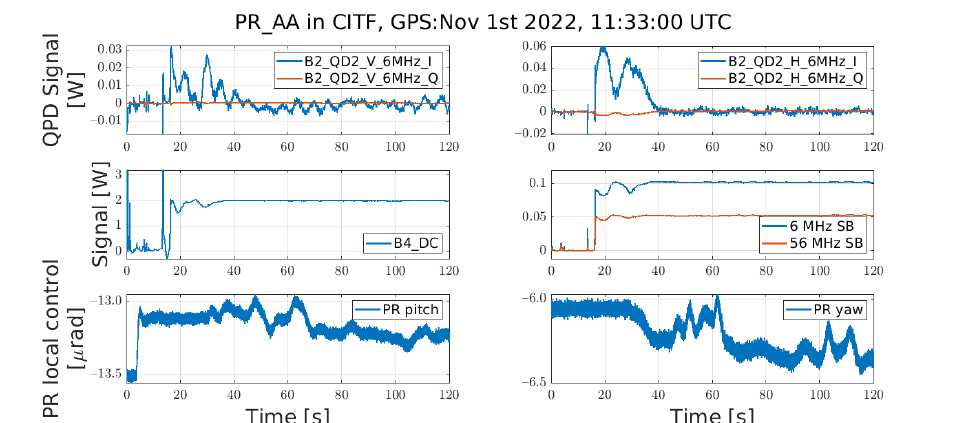
Figure 13. Example of the engagement of the angular control of the PR mirror after the lock of the DRMI. The top plots show the I and Q projections of the angular error signals for yaw (horizontal) and pitch (vertical) DOFs of the PR mirror. The Q is almost flat, signaling a good tuning of the demodulation phase. The middle plots show the behavior of the global power (left) and the sidebands’ power (12MHz and 112MHz, right) picked-off in the PRC. The bottom plots show the pitch (left) and the yaw (right) of the PR mirror as detected by the optical levers for its